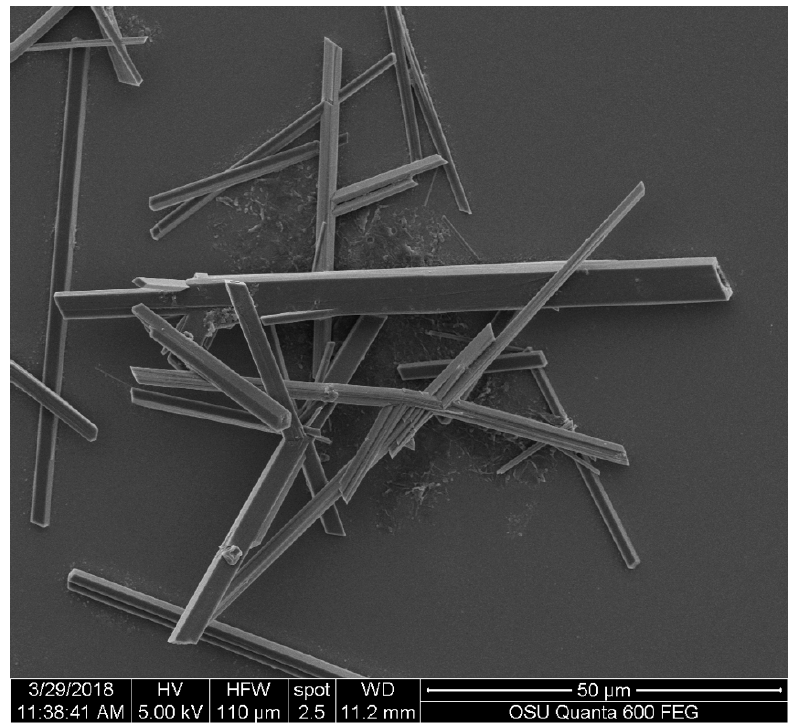
Figure 3. Scanning electron microscopy (SEM) image of the crystals produced by the pigment of S. cuboideum detailing their angular nature. Image obtained with an FEI QUANTA 600F environmental SEM.